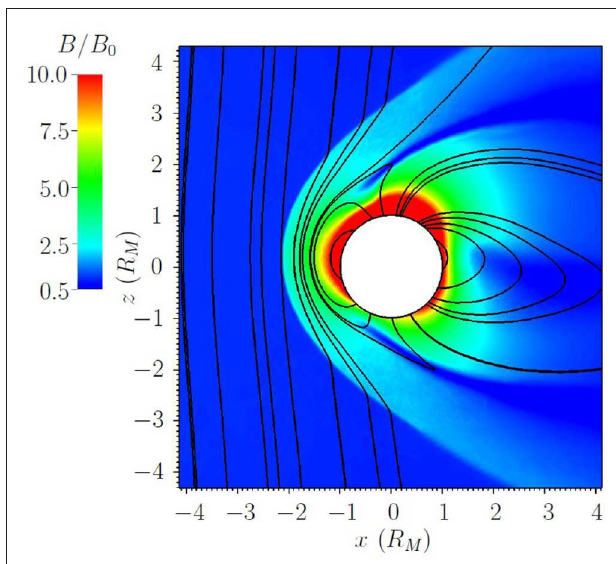
FIGURE 1 | Simulated magnitude of the magnetic field B in multiples of the solar wind magnetic field B 0 = 20nT in the x - z -plane. The black lines describe the magnetic field lines. The white circle of radius 1 R M symbolizes Mercury. The implemented internal Gauss coefficients are g 0 1 = − 190nT and g 0 2 = − 78nT [17].